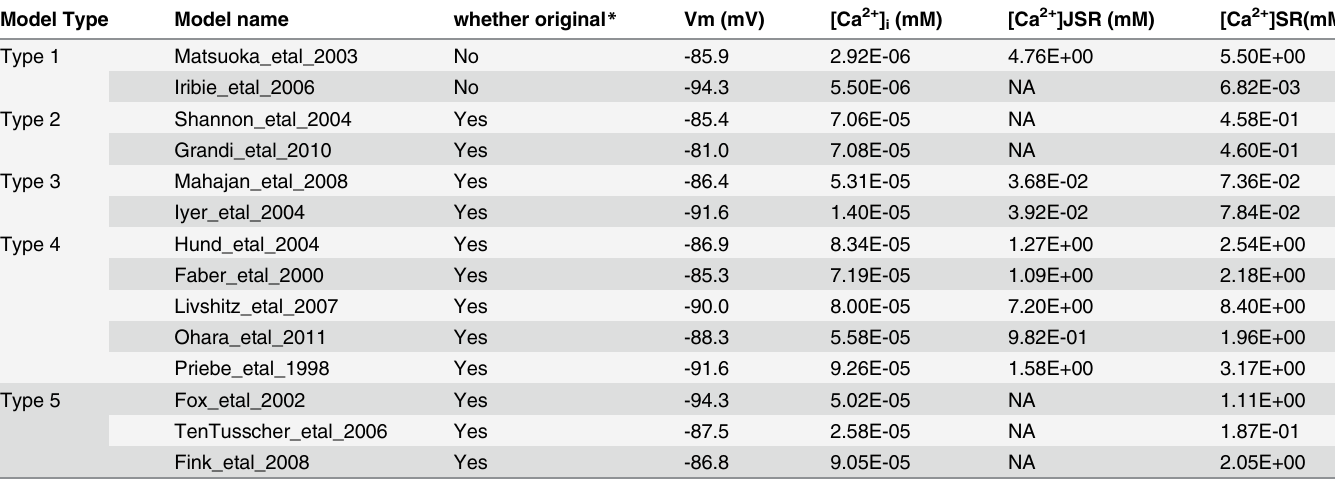
Table 4. Quiescent state variables: membrane voltage, intracellular calcium condensation and JSR (or SR) calcium condensation. Model